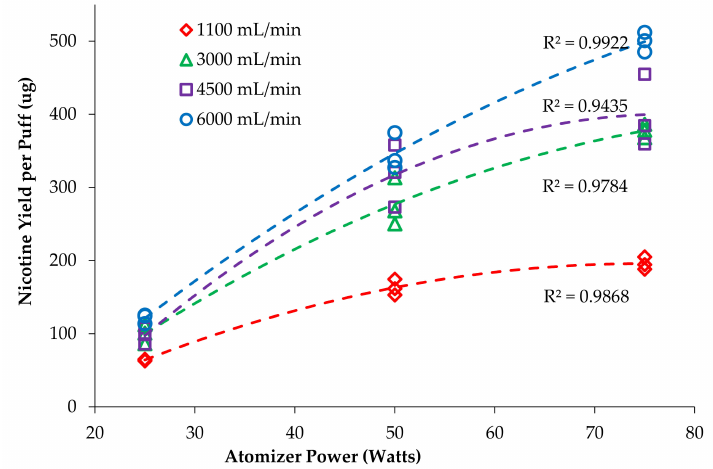
Figure 2. Effect of power on nicotine yield at different flow rates.